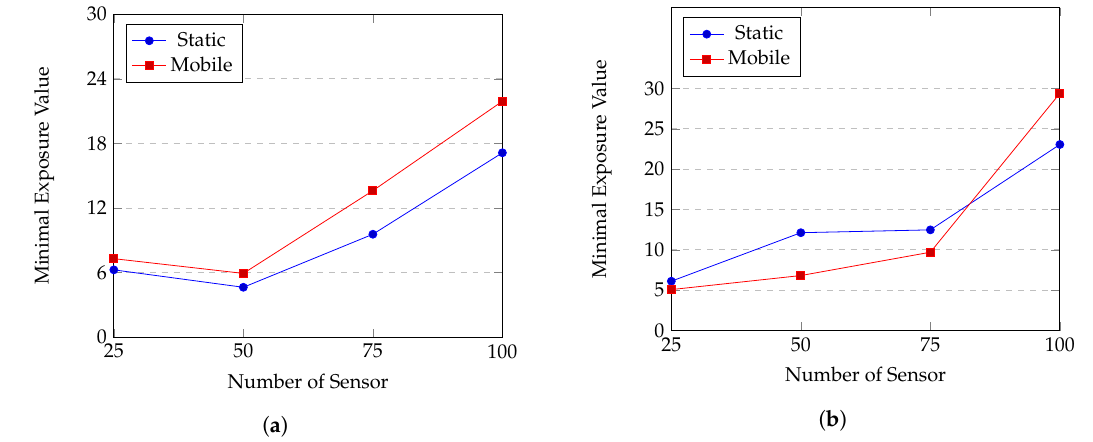
Figure 15. Performances of a mobile sensor network and a static sensor network: ( a ) Gauss distribution; ( b ) uniform